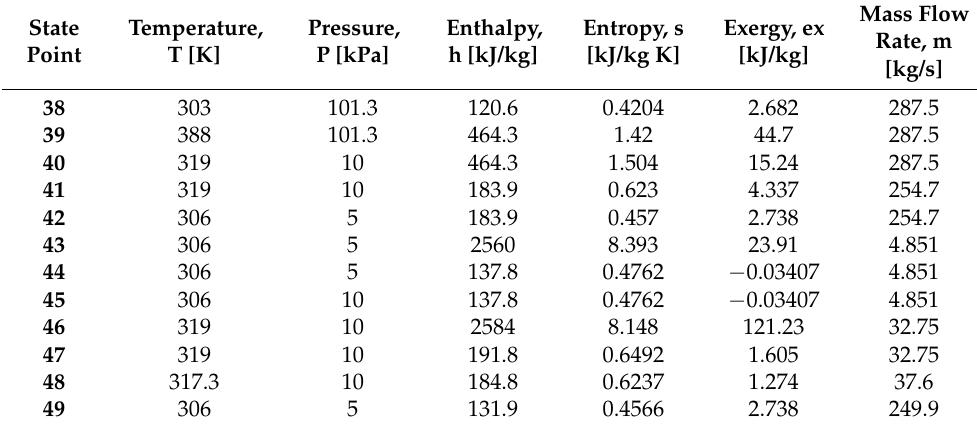
Table 4. State point values of Temperature, Pressure, Enthalpy, Entropy, Exergy and Mass flow rate of Double Flash Desalination Cycle.